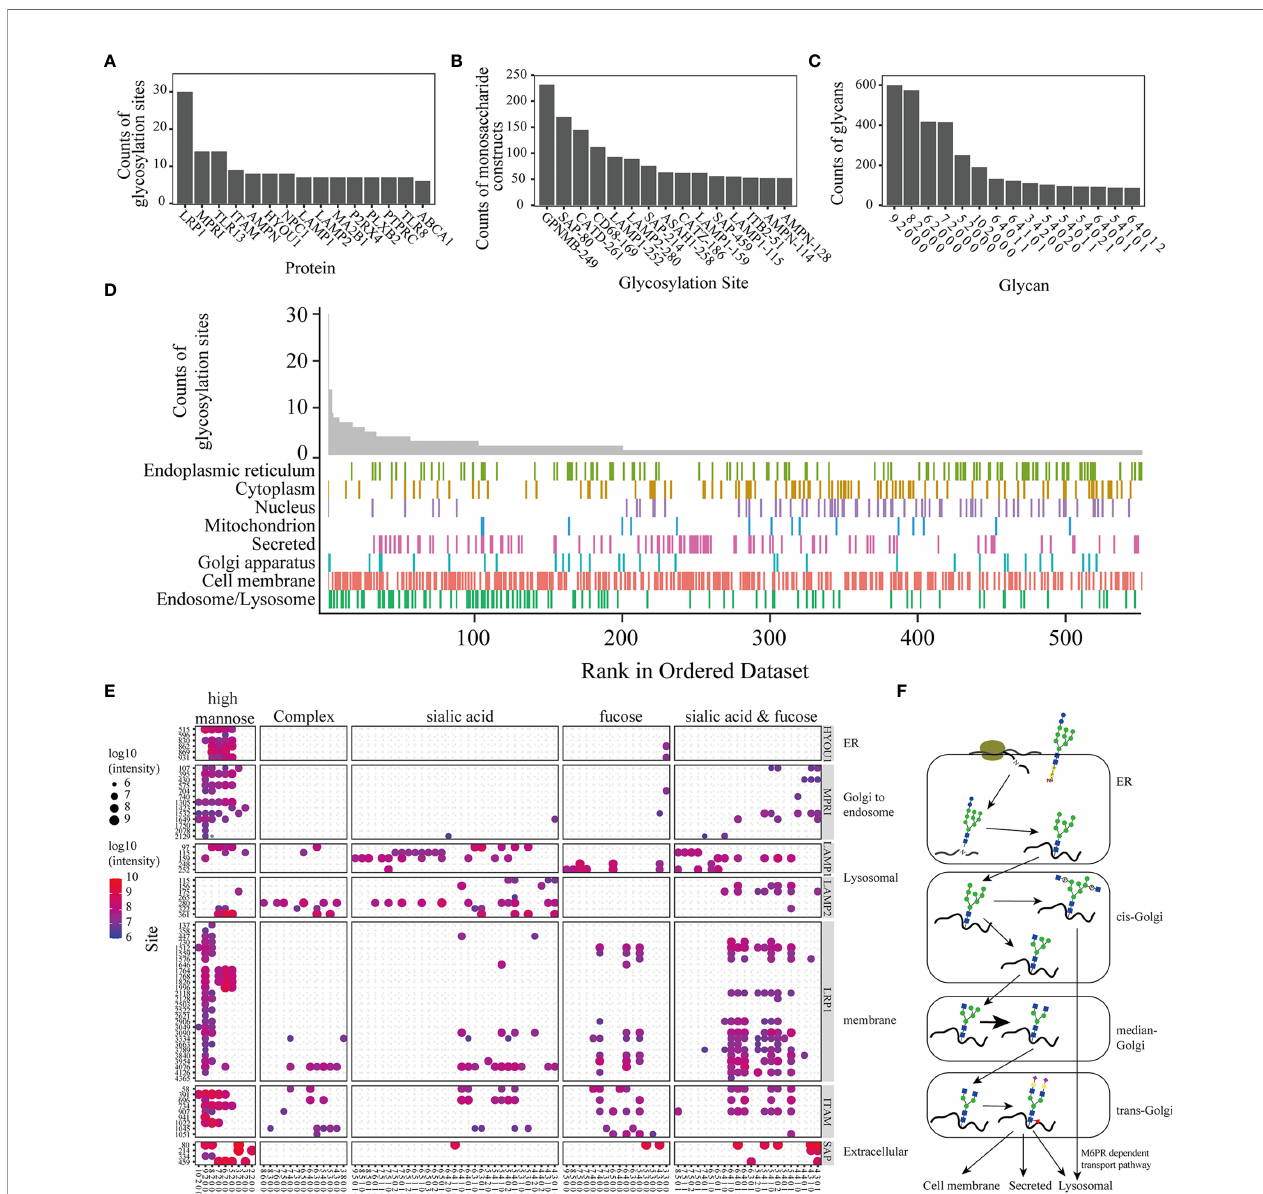
FIGURE 2 | Analysis of the precise N-glycoproteome. Bar plot of the top 15 glycoproteins with most glycosylation sites (A) , the glycosylation sites with the top 15 monosaccharide constructs (B) , and the monosaccharide construction (the ‘ 9 2 0 0 0 ’ in the fi gures represent glycans constituted by 9 Hex, 2 HexNAc, 0 NeuAc, 0 NeuGc, and 0 fucose. The remaining molecules were similarly described) on most glycopeptides (C) . The distribution of glycoproteins in different subcellular locations (D) . Glycan distribution of the glycoproteins. The size and color of the dot represent the total intensity of the intact glycopeptides (E) . Diagram of the glycosylation progress in different subcellular organelles (F)